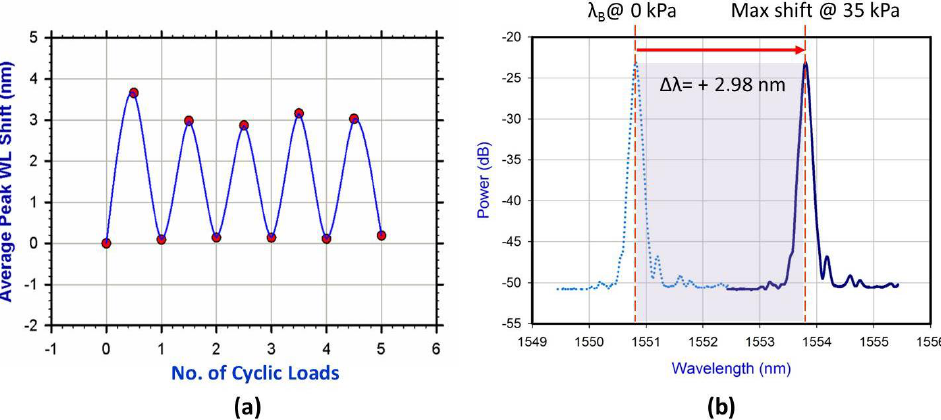
Figure 7. ( a ) Sensor repeatability test. Pressure was changed cyclically from minimum (0 kPa) to maximum (35 kPa) for five times to test the repeatability and reliability of the sensor. The solid line is for indicative purposes only. ( b ) The spectral response of FBG used without pressure (dotted line) and that with maximum applied pressure at ~35 kPa (Solid line) for the second cyclic applied